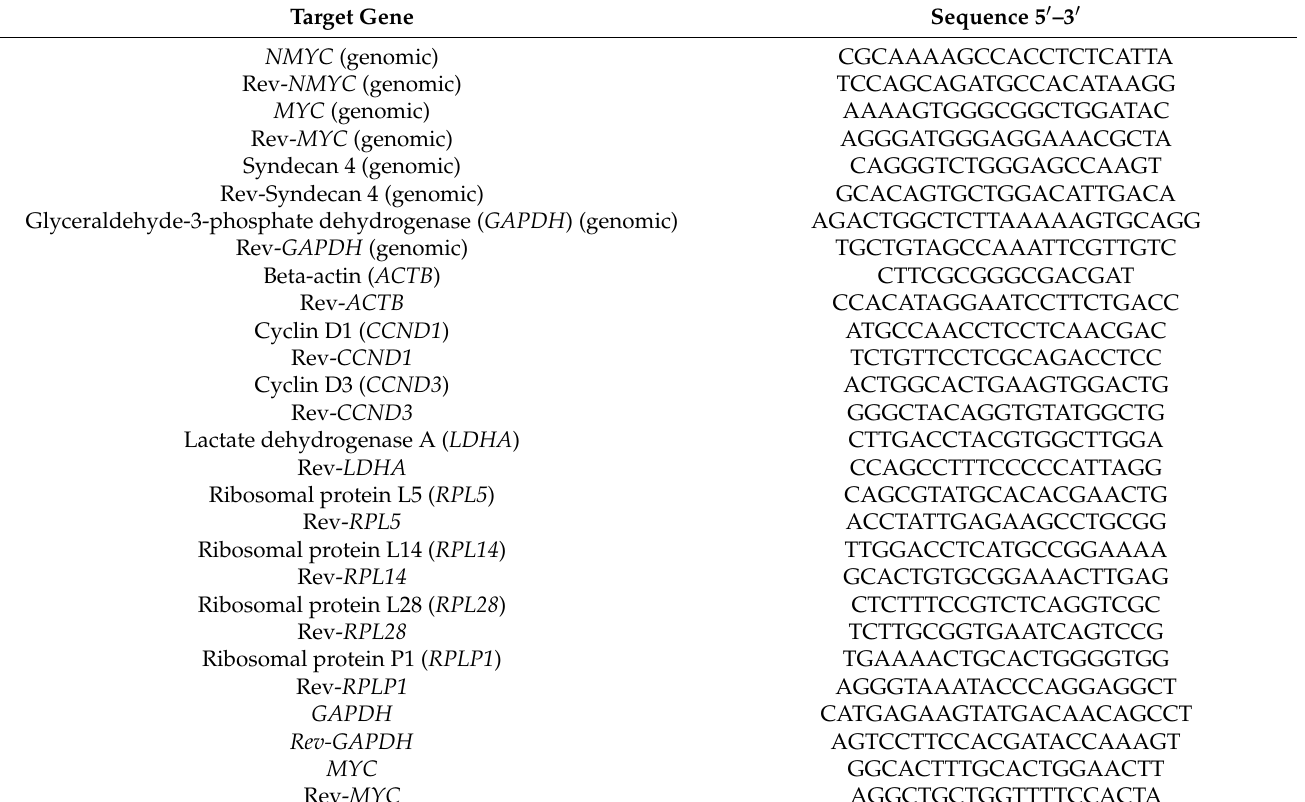
Table 1. Primer sequences for quantitative polymerase chain reaction. Target